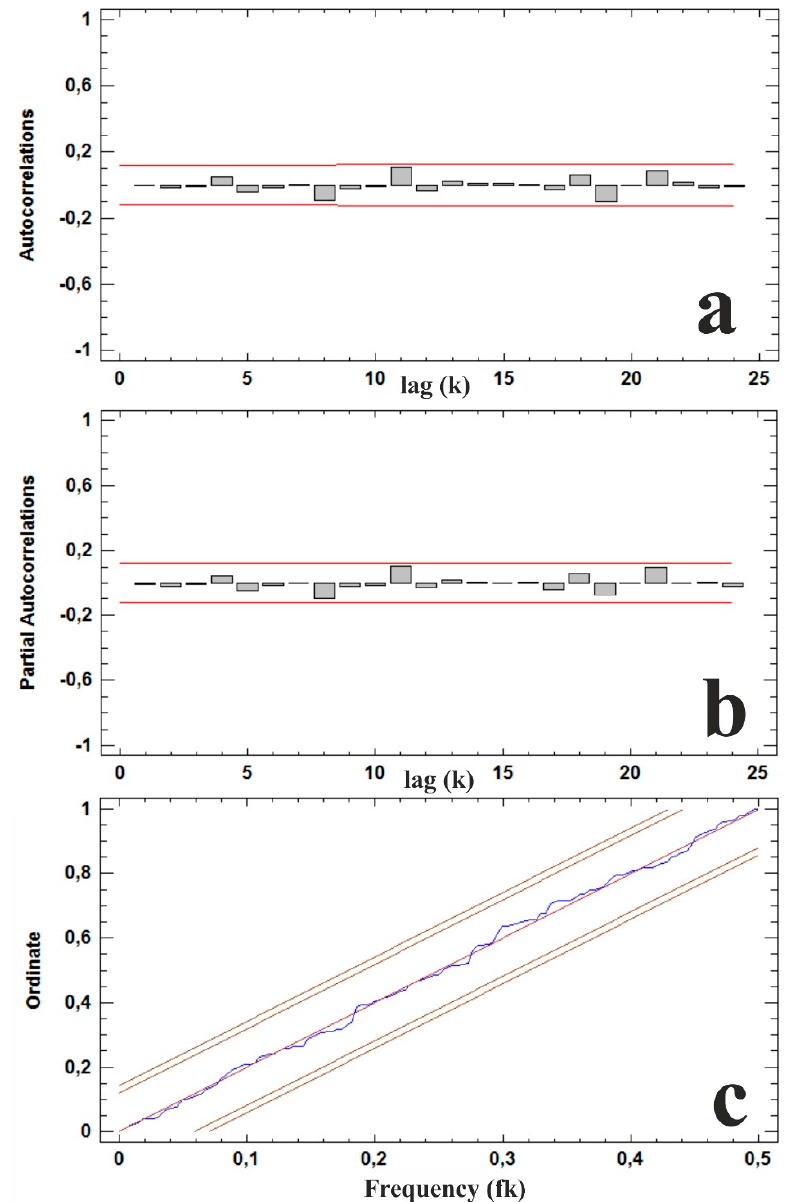
Figure 9. ( a ) Autocorrelation Function (ACF) ( b ) Partial Autocorrelation Function (PACF) and ( c ) Cumulative Periodogram [C(f k )] of the residuals of Kefalovriso karst spring using SARIMA model (4,1,1) (1,1,1) 12 for the time period 1974–1993.